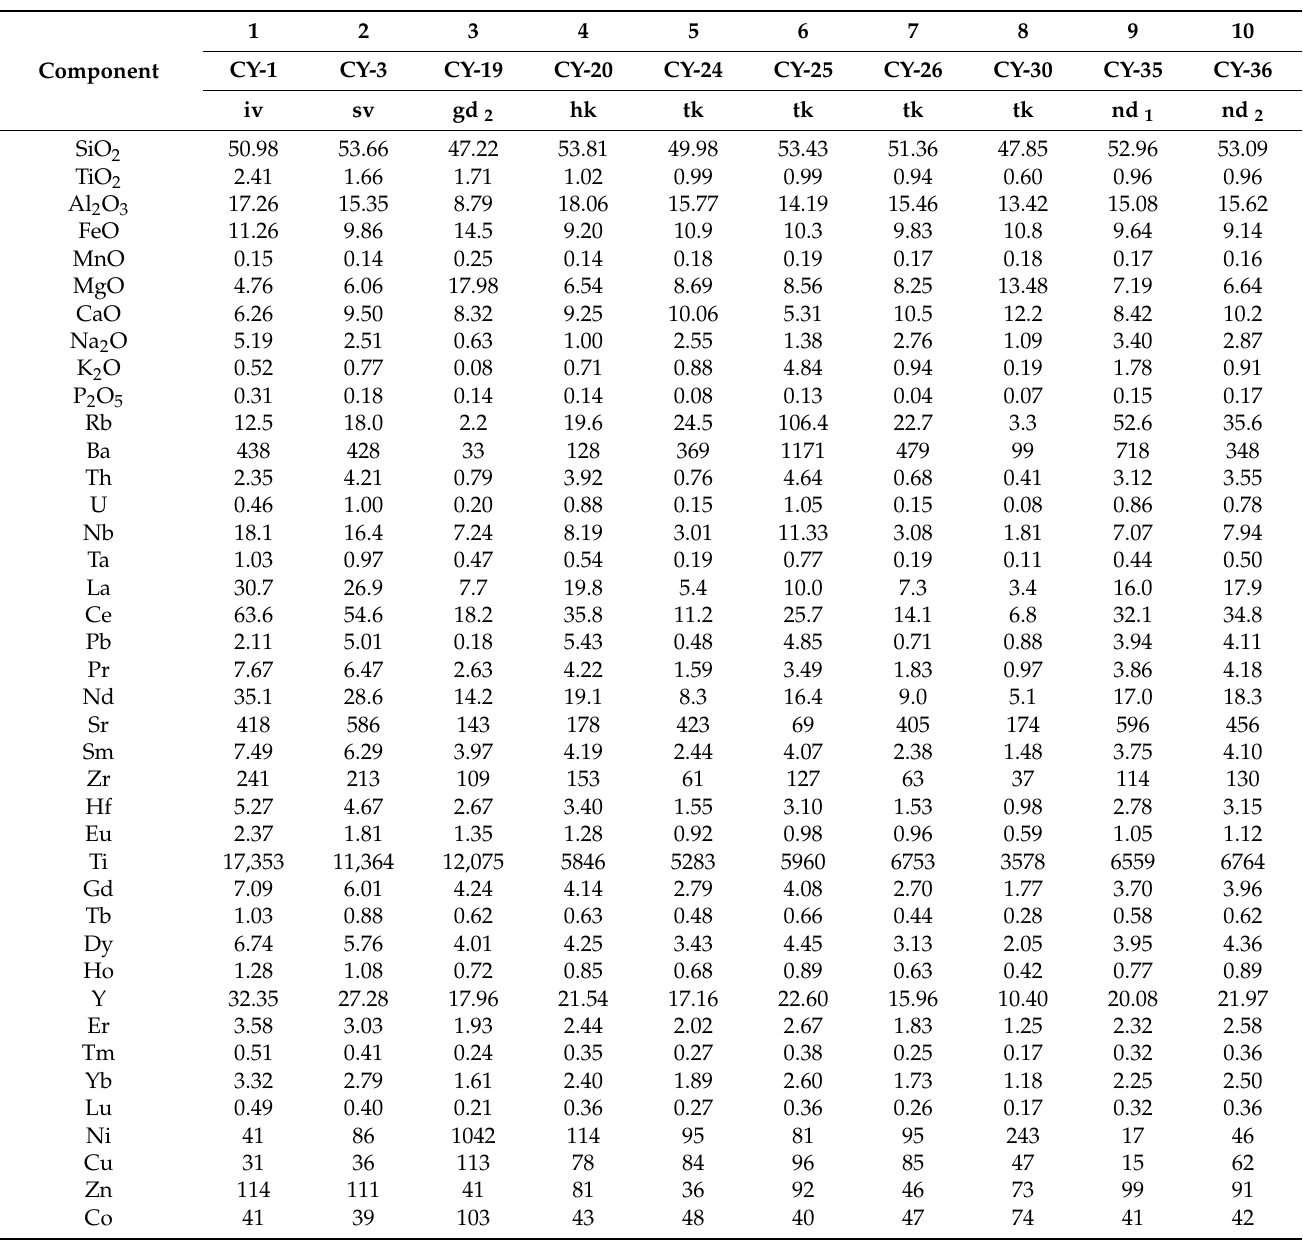
Table 4. Representative volcanic rock compositions in Mount